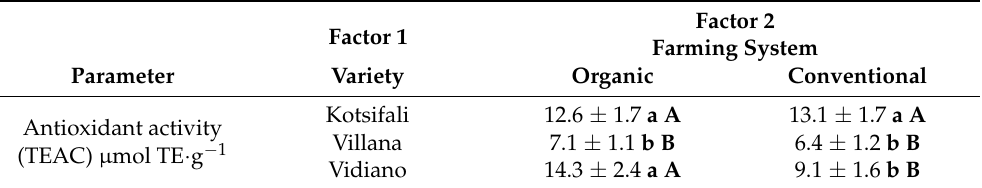
Table 2. Interactions means ± SE for the effects of variety farming system on total antioxidant activity in table